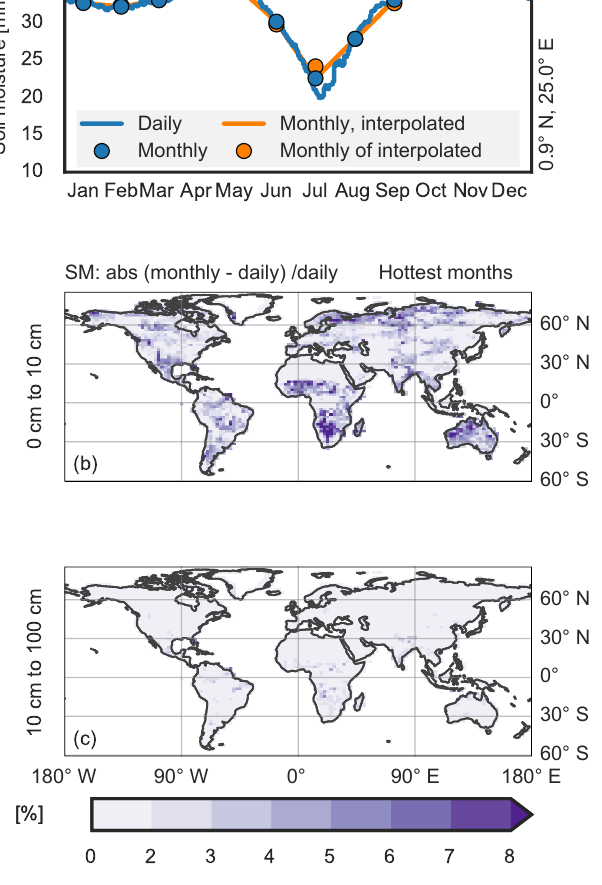
Figure 3. Difference between interpolated monthly and daily SM. (a) Seasonal cycle of median SM climatology for one grid point in central Africa (0.9 ◦ N, 25 ◦ E), illustrating the difference between daily and interpolated monthly values. ( b and c ) Absolute difference [%] in the median SM climatology between daily and interpolated monthly values in the surface layer (0 to 10cm, b ) and in 10 to 100cm depth (c)